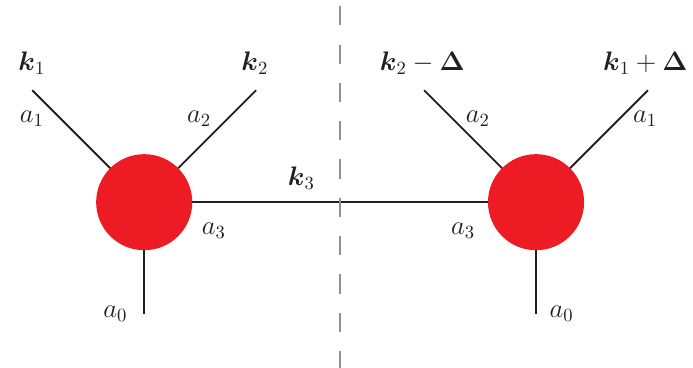
Figure 5: Assignment of transverse momenta in of a real graph. Note that compared with the symmetric assignment in [ 43 ] we have shifted the integration variables k and k such that ∆ appears only on the r.h.s. of the 2